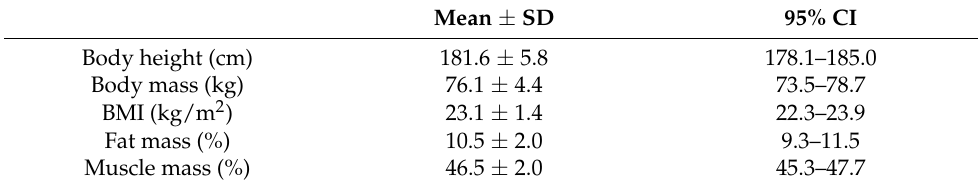
Table 1. Anthropometric characteristics.